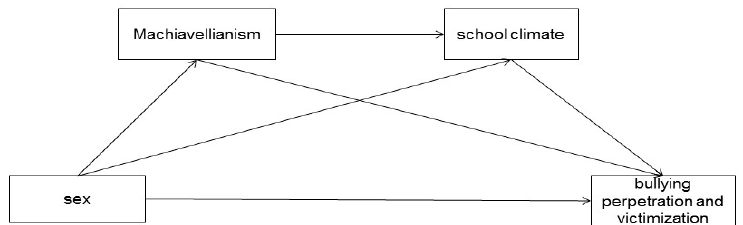
Figure 1. Hypothesized relationships among sex, Machiavellianism, school climate, and bullying perpetration and victimization.